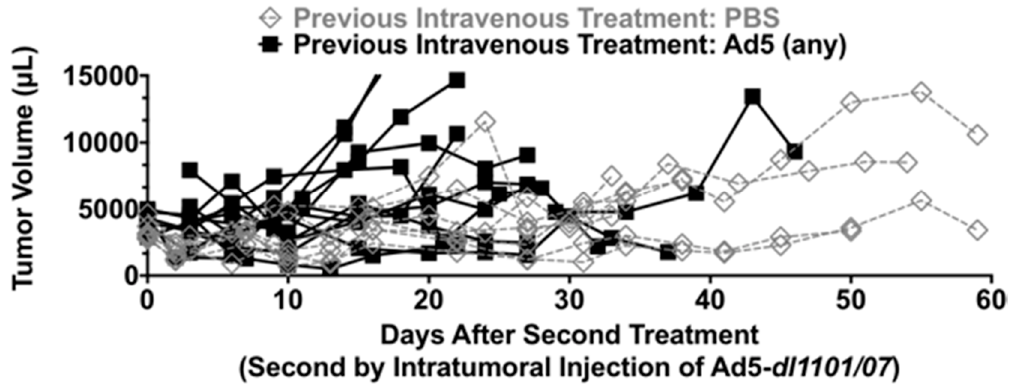
Figure 5. Tumor sizes after second treatment by intratumoral Ad5- dl 1101/07-ADP